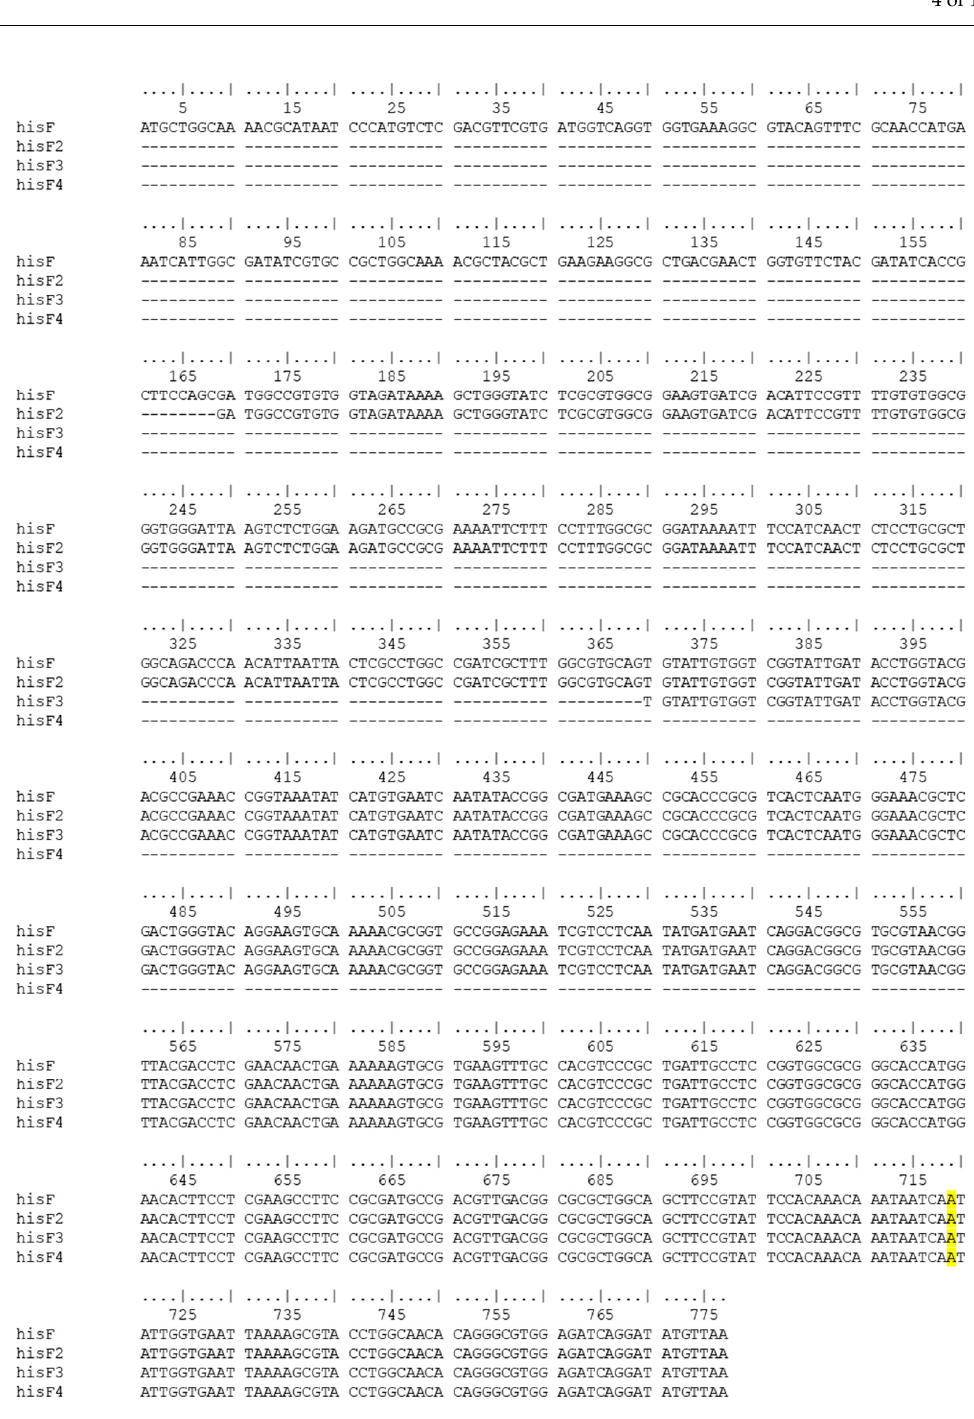
Figure 1. Nucleotide sequences of the hisF (777 bp), hisF2 (609 bp), hisF3 (408 bp), and hisF4 (217 bp) fragments. The nucleotide which is deleted in E. coli FB182 ( hisF892 ) is highlighted in yellow. Amplicons were visualized through a 0.8% w/v agarose gel electrophoresis and puri- The same procedure was used for the entire E. coli wild-type hisIE gene (NCBI ID: fied. The addition of A-overhangs was performed through incubation at 72 ◦ C for 30 min 946515) (869 bp). in the presence of 1 U of DreamTaq Polymerase (ThermoFisher Scientific, Waltham, MA, USA), before proceeding with the TA cloning in the pGEM-T Easy vector. E. coli DH5 α chemically competent cells were used for all cloning procedures. Plasmid extraction was performed using QIAprep Spin Miniprep Kit (Qiagen, Hilden,